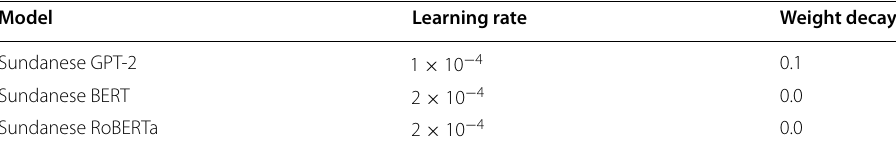
Table 2 Learning rate and weight decay of each of the pre-trained Sundanese models